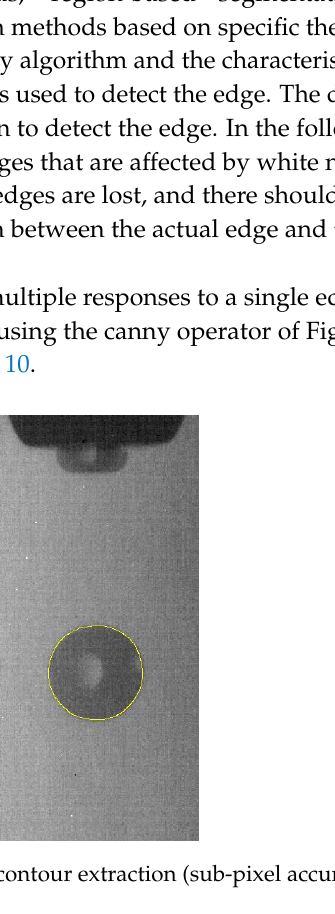
Figure 9. Droplet image preprocessing. ( a ) original image, ( b ) median filter, ( c ) binarization, ( d ) connection, ( e ) feature selection, ( f ) region fill, ( g ) region dilation, and ( h ) image difference.